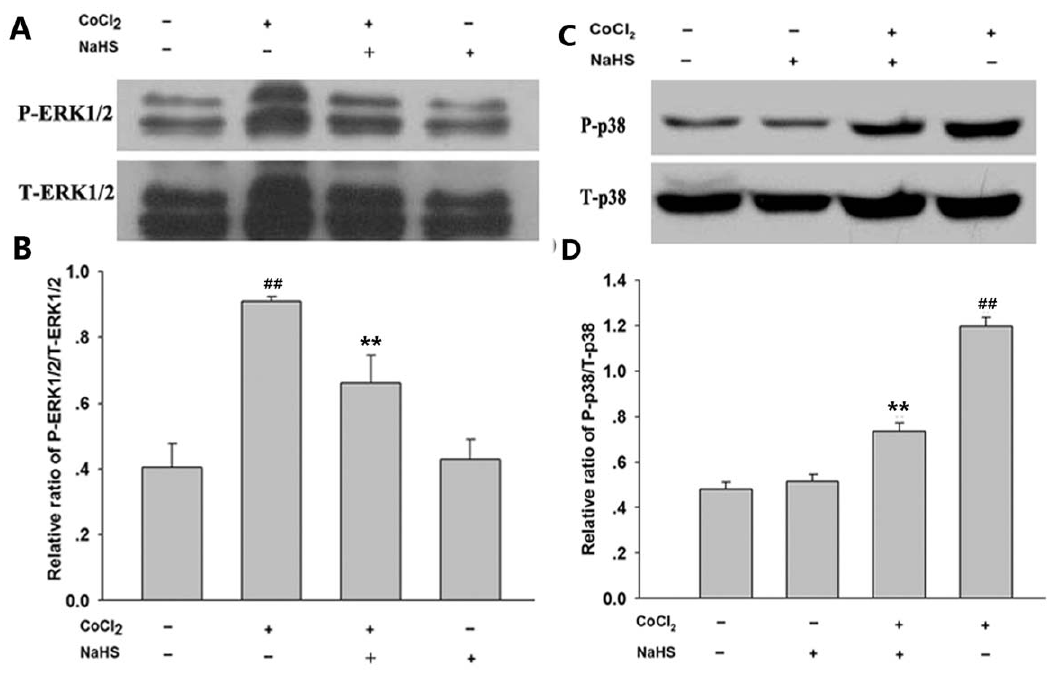
Figure 6. NaHS attenuated CoCl 2 -induced ERK1/2 and p38 MAPK phosphorylation in PC12 cells. PC12 cells were preconditioned with 400 m mol/L NaHS for 30min before exposure of cells to 600 m mol/L CoCl 2 for 30 min (A) and (B) or for 120min (C) and (D). Cell lysates were subjected to western blot analysis using anti-p-ERK1/2 and anti-ERK antibody (A and B) or anti-p-p38 and anti-p38 antibody (C) and (D). Panels (B) and (D) show denstiometric analysis for the data from (A) or (C), respectively. Data are presented as mean 6 SE from independent experiments preformed in triplicate. ## P , 0.01 compared to the control group, ** P , 0.01 compared to the CoCl 2 group.